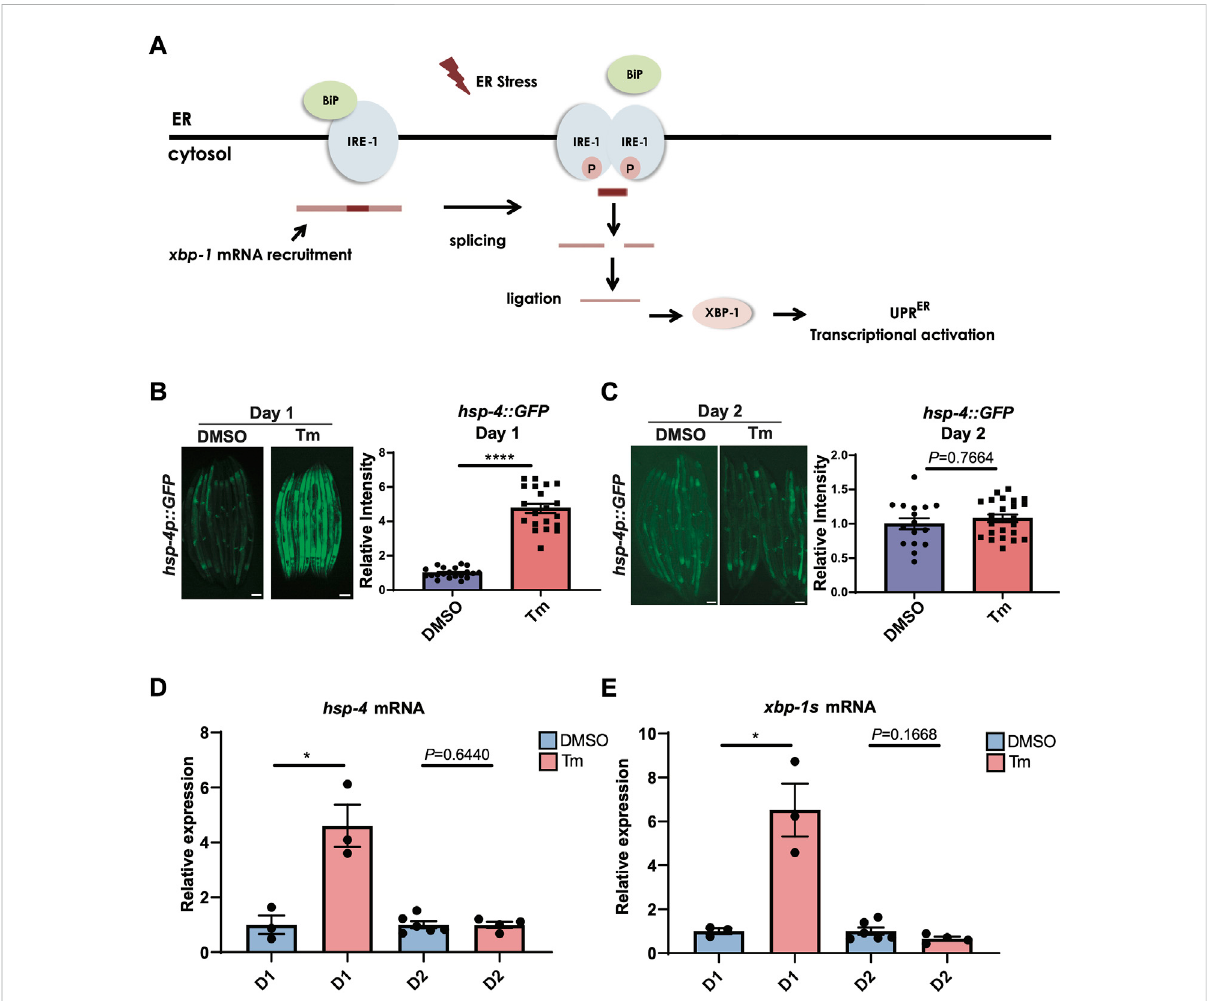
FIGURE 1 UPR ER activation is lost during the fi rst day of adulthood as animals enter the reproductive period. (A) Schematic representation of the IRE-1/ XBP-1 branch of the UPR ER in C. elegans . IRE-1 is a transmembrane resident ER protein that acts as a sensor of ER stress and transmits that information in a retrograde way to the nucleus. During stress, IRE-1 is autophosphorylated, dimerizes, and together with the RNA ligase RTCB-1 mediates the splicing of the xbp-1 mRNA in the cytosol, which is translated into an active transcriptional factor. XBP-1 regulates genes such as chaperones that act to alleviate proteotoxic stress in the ER. (B,C) Epi fl uorescence microscopy and quanti fi cation of the fl uorescence of animals at the beginning of (B) Day 1 (D1) or (C) Day 2 (D2) of adulthood after 6 h of treatment with tunicamycin (Tm) or DMSO. Scalebars, 200 μ m **** p < 0.0001 (Unpaired t test with Welch ’ s correction). (D,E) qRT-PCR measurement of (D) hsp-4 and (E) xbp-1s mRNA after 6 h of tunicamycin (Tm) or DMSO treatment. * p < 0.05 , Unpaired t -test (DMSO vs.